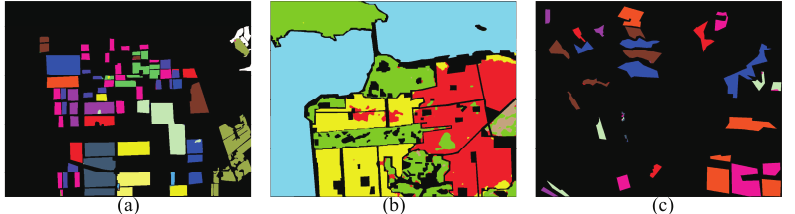
Figure 21. Classification maps of proposed method with polarimetric Feature Set II. ( a ) AIRSAR Flevoland dataset. ( b ) AIRSAR San Francisco dataset. ( c ) GF-3